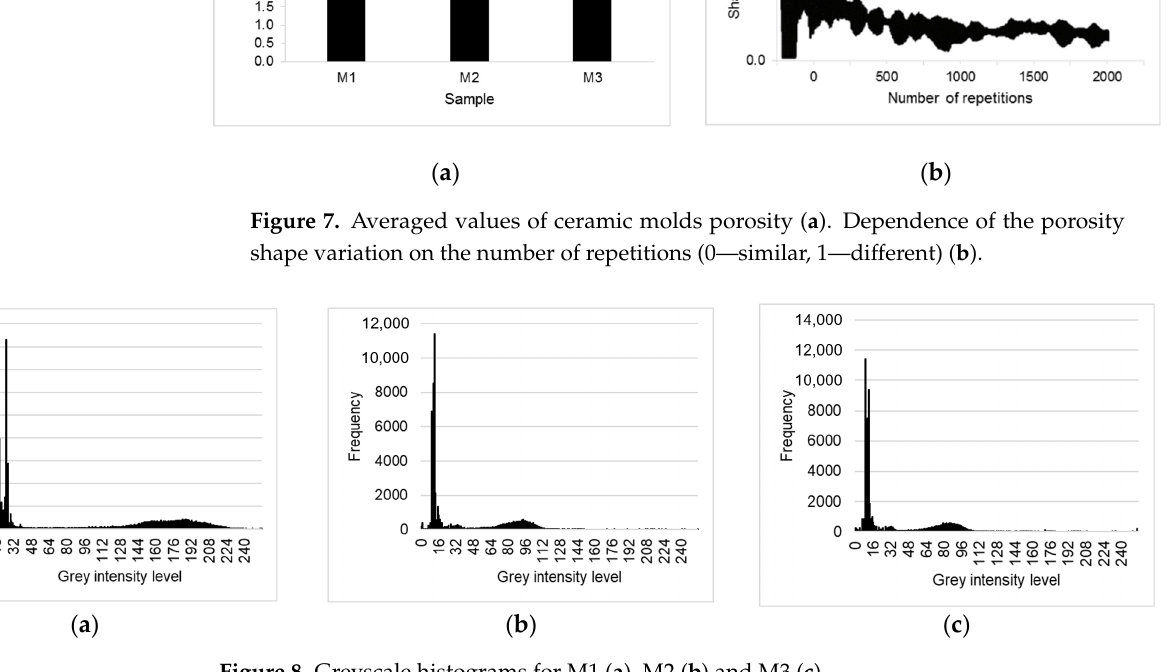
Figure 8. Greyscale histograms for M1 ( a ), M2 ( b ) and M3 ( c ).